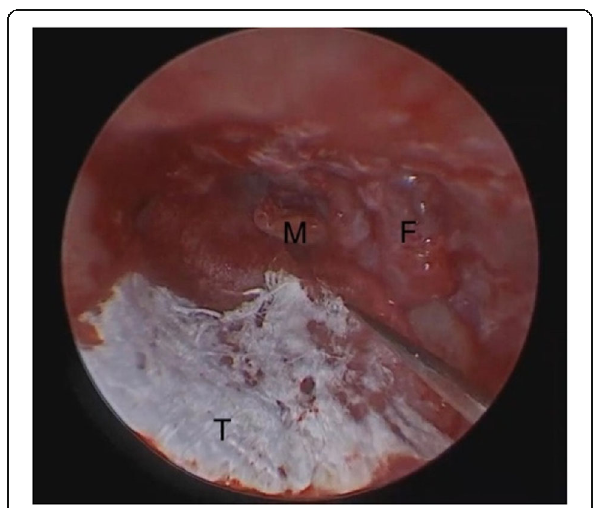
Fig. 3 Underlay of the Tutoplast graft. F, tympanomeatal flap; M, malleus; T, Tutoplast